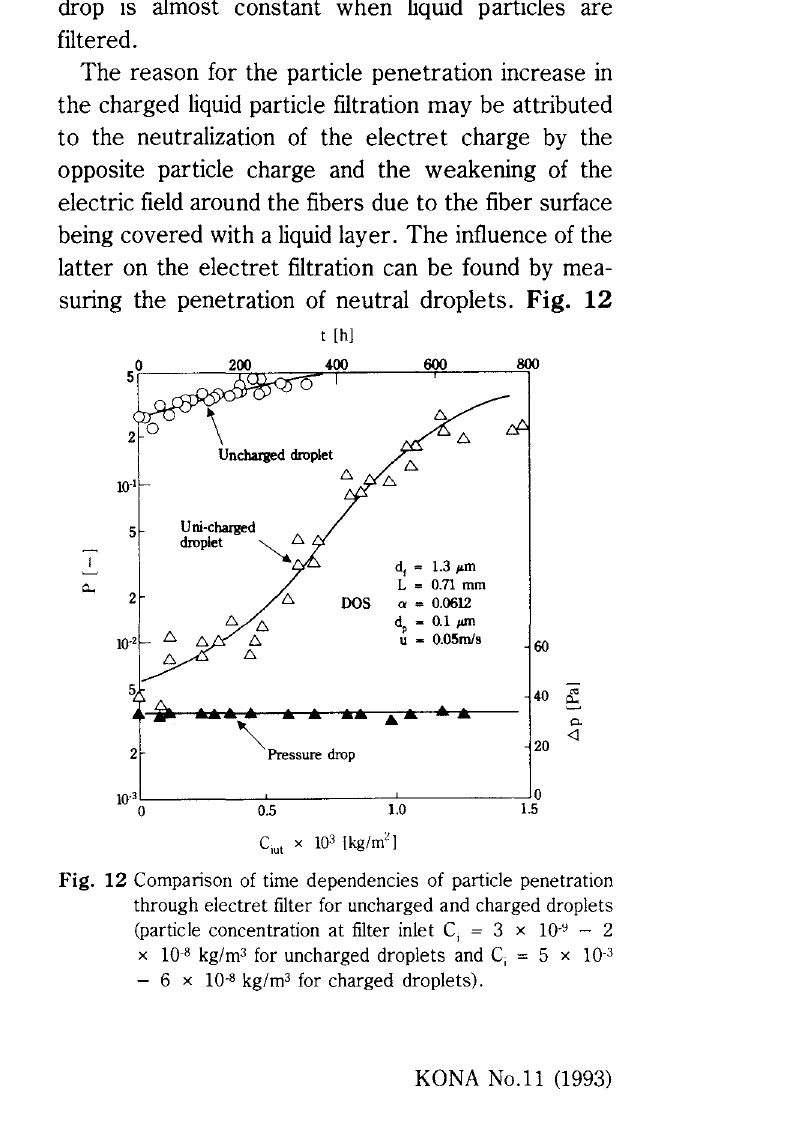
Fig. 11 Comparison of time dependencies of particle penetration and pressure drop through electret filter during the filtration of liquid and solid particles.